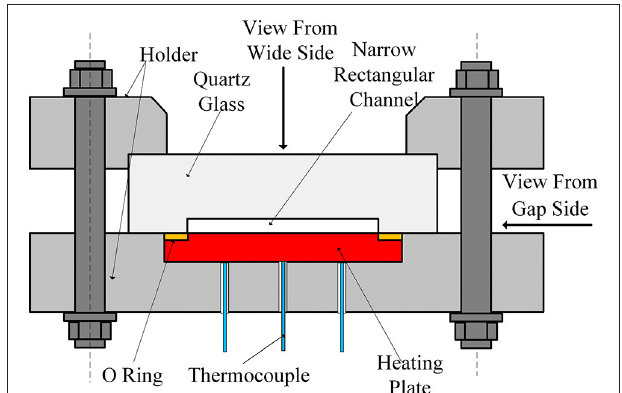
FIGURE 4 | Cross sectional view of test section.